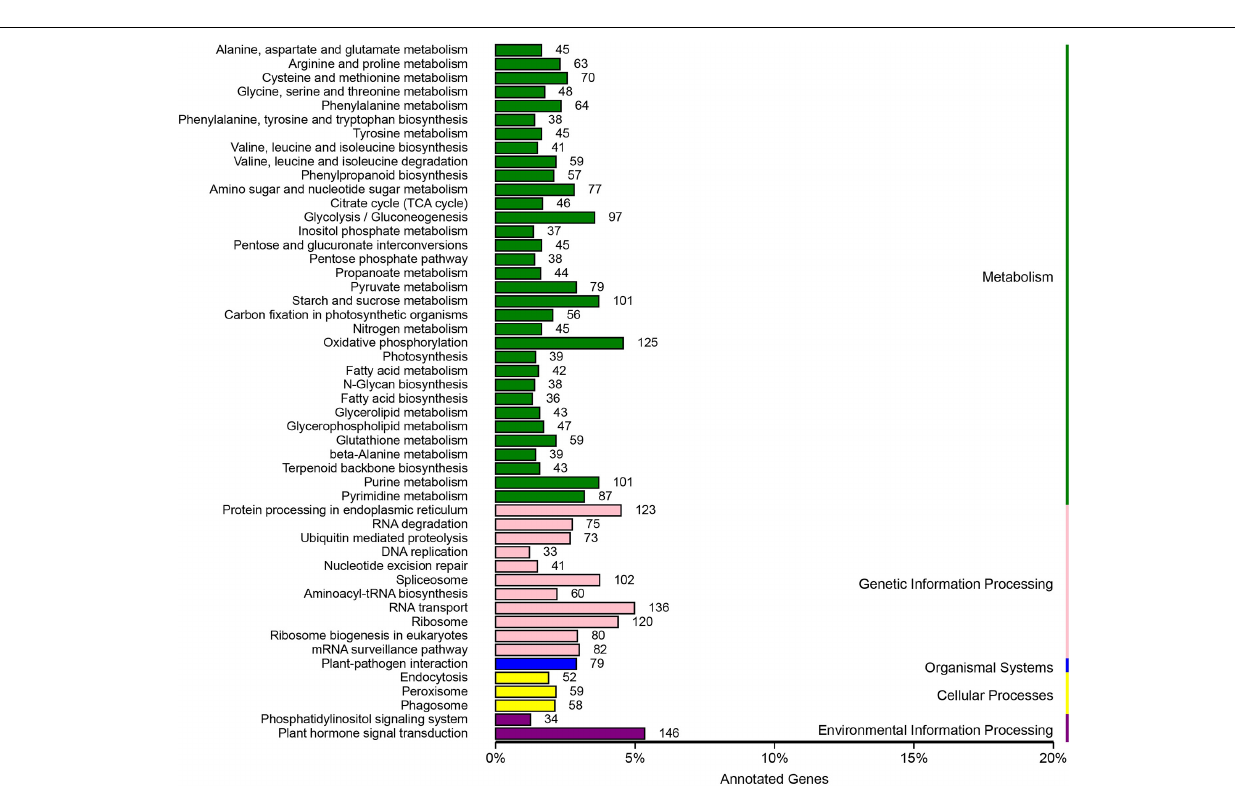
Frontiers in Ecology and Evolution |